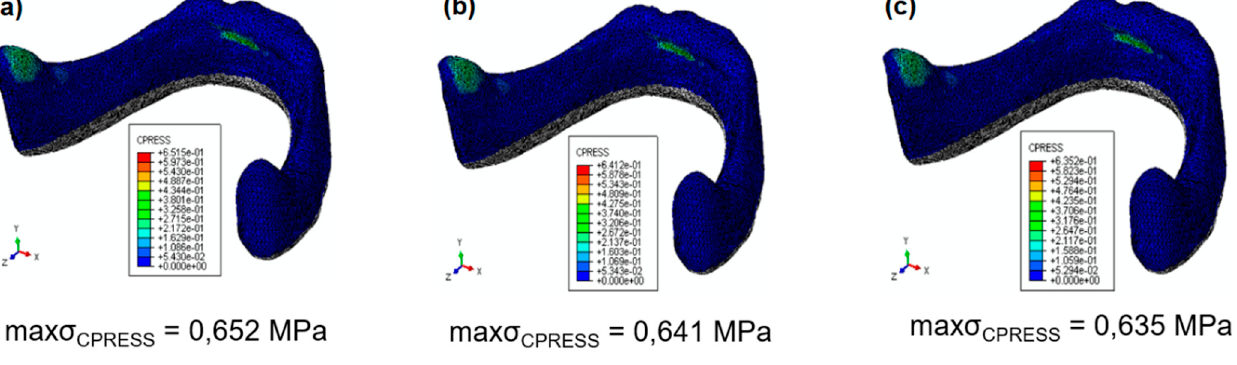
Figure 12. Comparison of the influences of applying POM matrices with three different retention levels on stress distribution results for canine load case and ( a ) POM-1, ( b ) POM-2, and ( c ) POM-3.